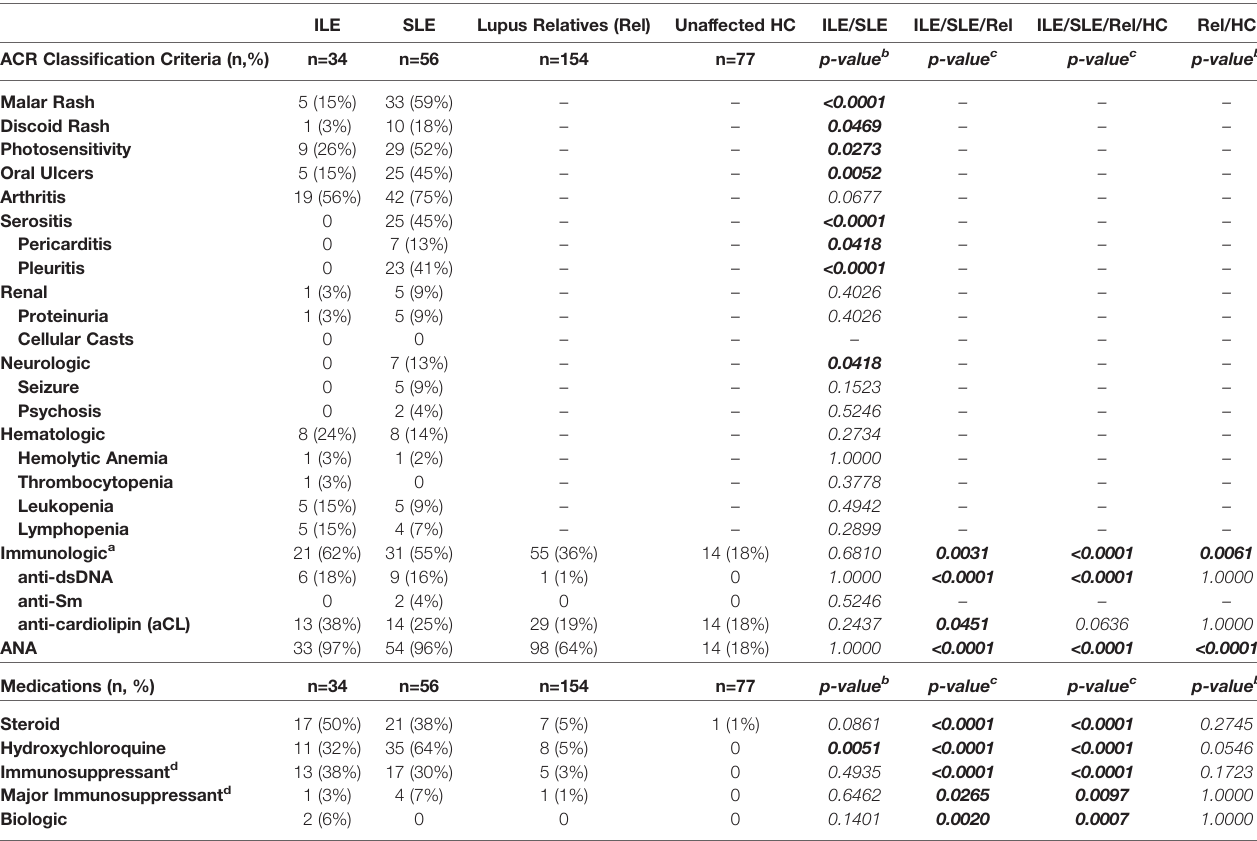
TABLE 4 | ACR Criteria and Medication in LAUREL Nested Cohort at Follow-up (After SLE